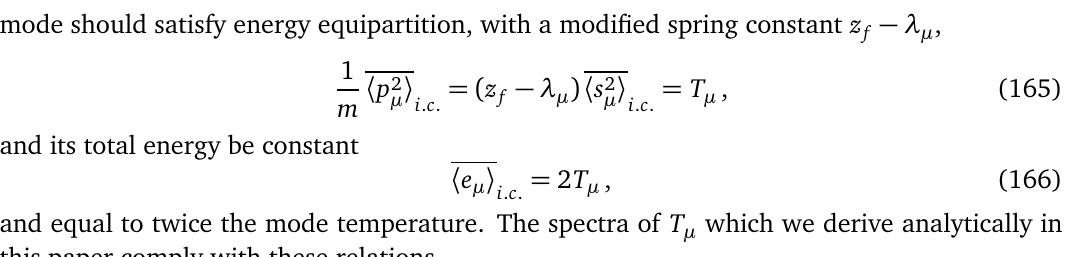
Figure 15: Comparison of the dynamic and GGE results in phase IV, with energy injection. The quench parameters are T (b) 〈 s 2 ( λ ) 〉 and (c) GGE Lagrange multipliers γ ( λ ) . The grey curves are the initial